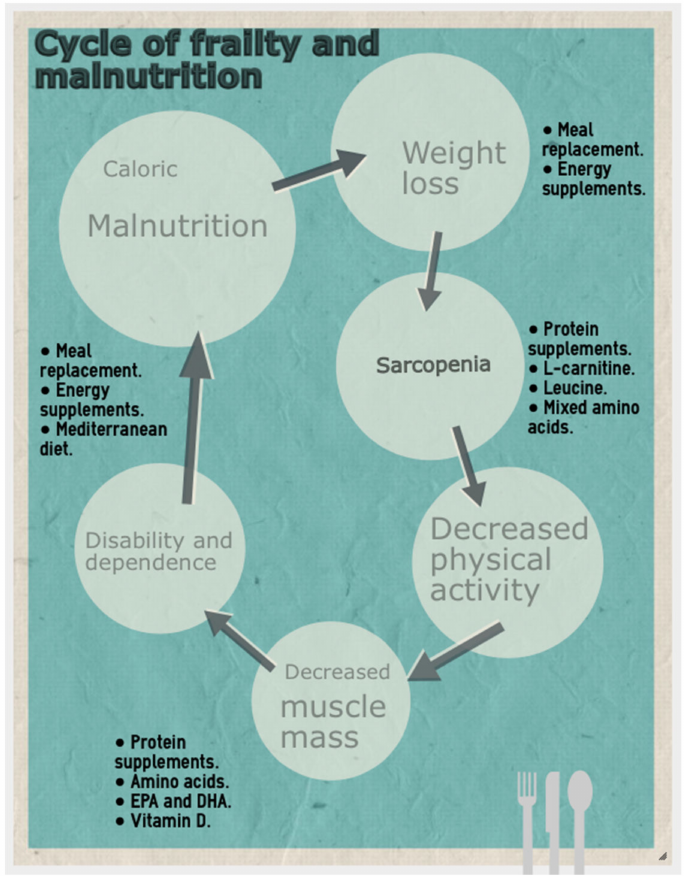
Figure 1. Frailty development cycle, adapted from Fried et al.